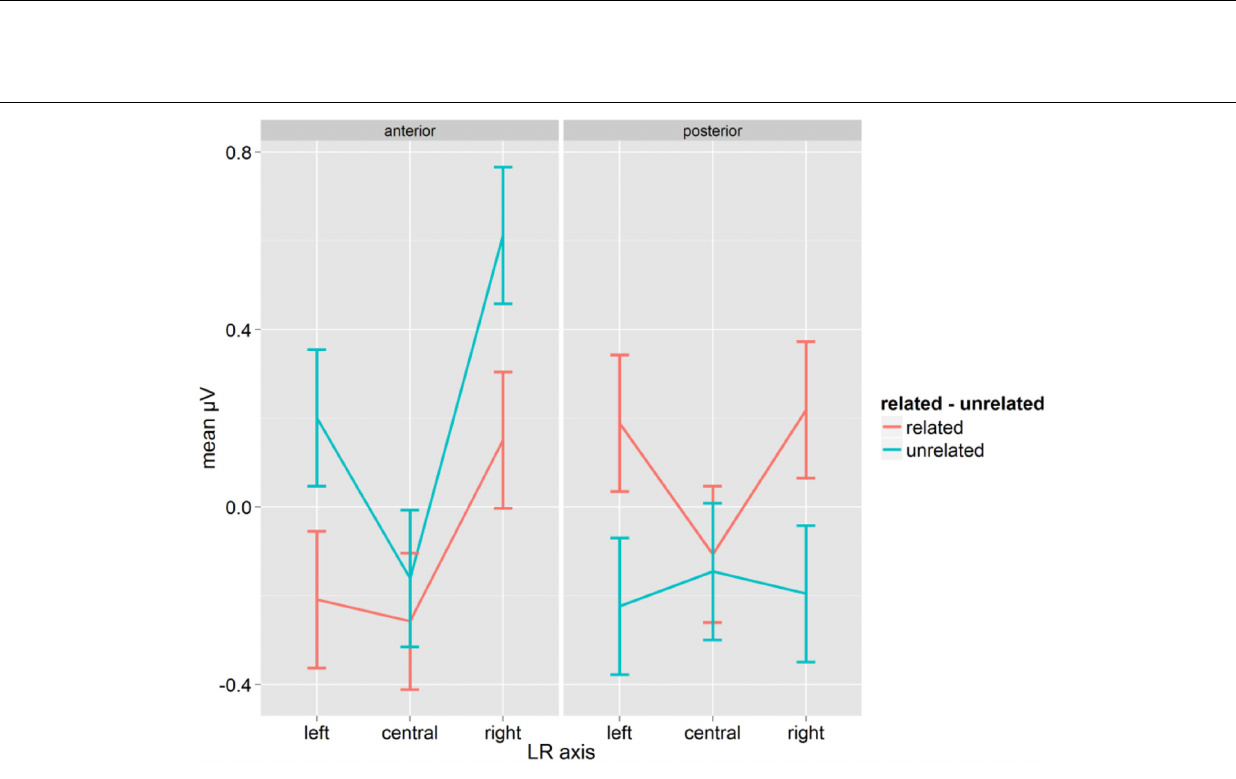
FIGURE 3 | Mean µ V for pseudowords as a function of conditions for the time-window 200–300ms; error bars represent Fisher’s least significant differences.